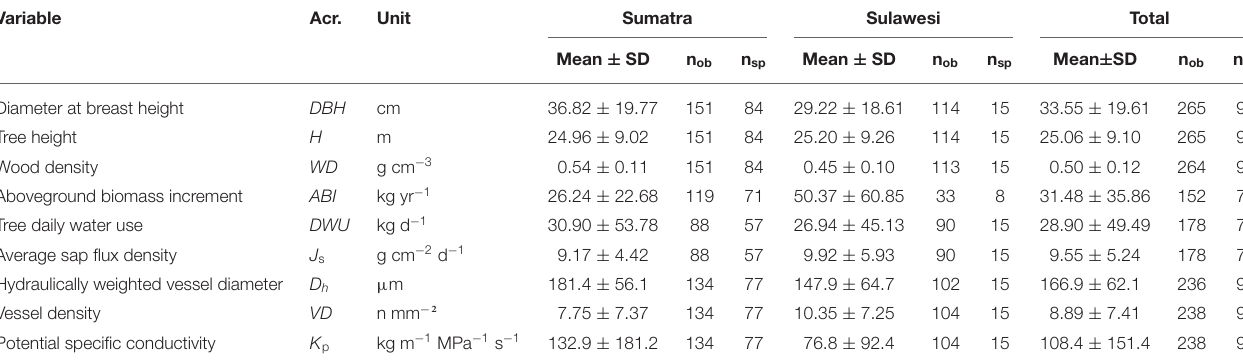
TABLE 1 | List of selected tree traits for the Sumatra and Sulawesi samples. Variable